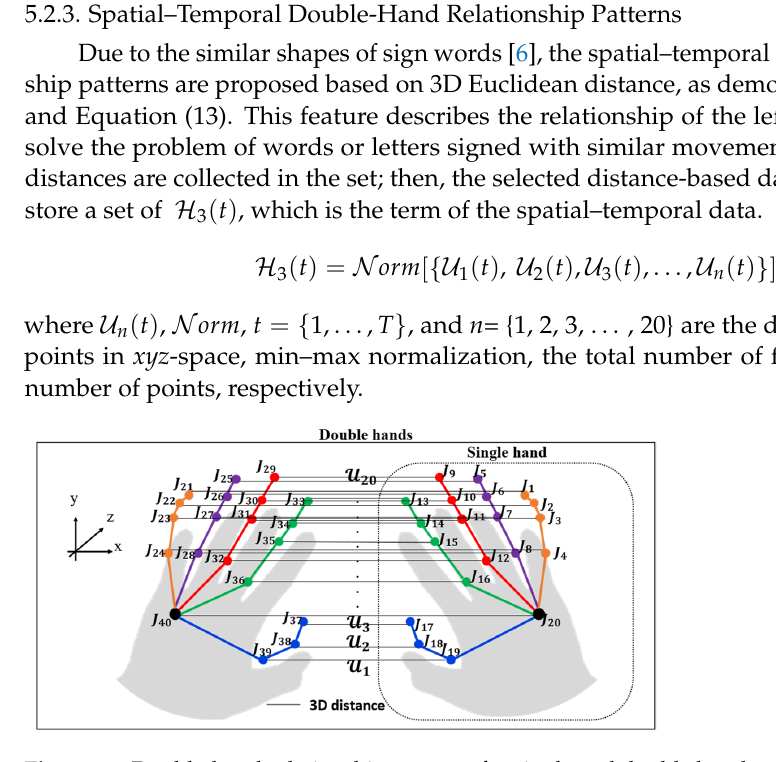
Figure 10. Double ‐ hand relationship patterns for single and double hands. Figure 10. Double-hand relationship patterns for single and double